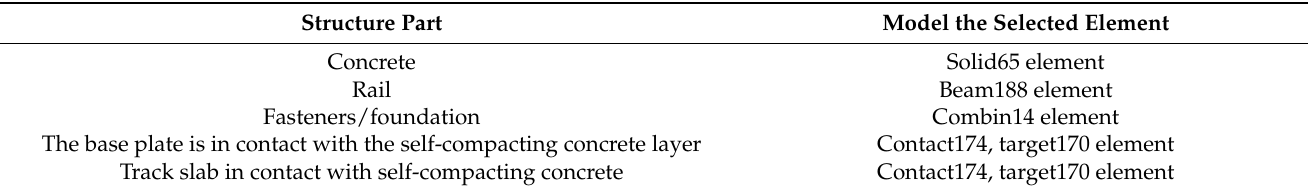
Table 3. Finite element for each structure.